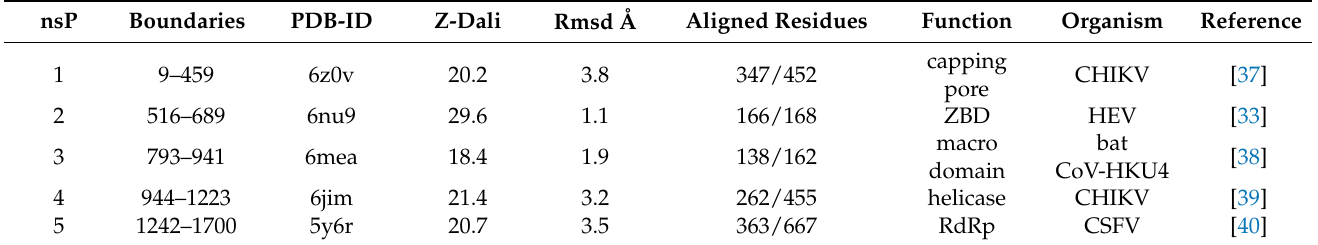
Table 1. nsP boundaries and structural similarity with viral proteins deposited in the PDB. CHIKV, Chikungunya virus; ZBD, Zinc-binding domain; CoV, coronavirus; CSFV, classical swine fever virus; RdRp, RNA-dependent RNA